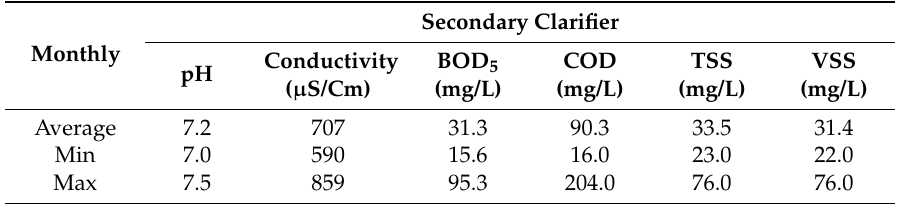
Table 3. Monthly averaged and range of physicochemical